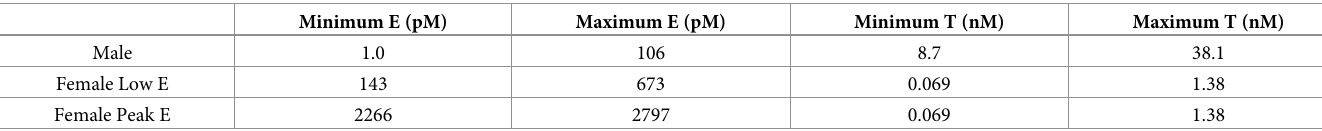
Table 3. Estrogen and testosterone ranges for males and females. These concentrations were obtained from Greenspan et al. (2004)